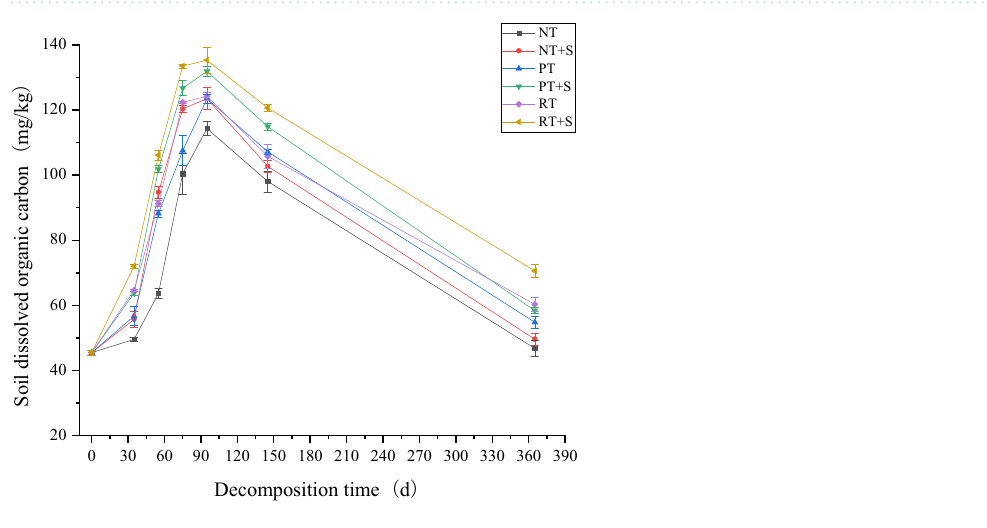
Figure 6. Changes of soil dissolved organic carbon under different returning